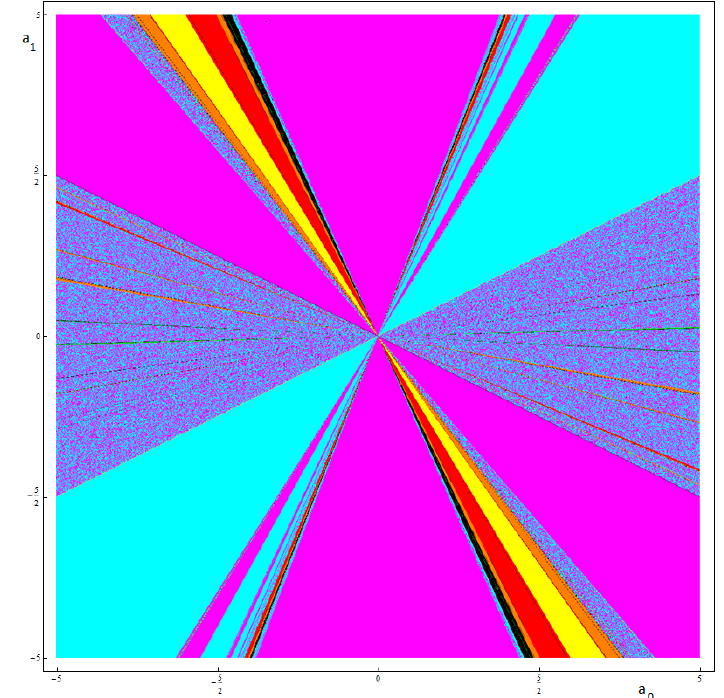
Figure 4. Parameter space associated to the free critical point cr 1 ( a 0 , a 1 )